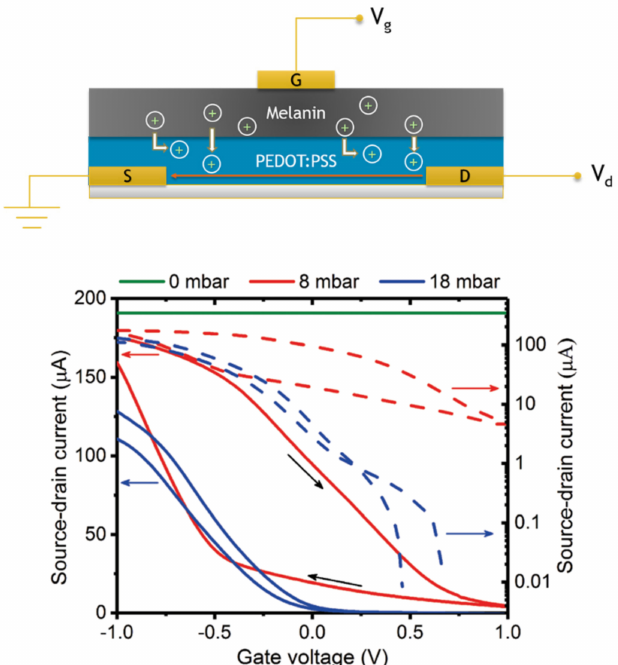
Figure 14. ( Top ) A schematic of the solid state organic electrochemical transistor from Sheliakina et al. The three terminal device is made of a bilayer utilizing poly(3,4-ethylenedioxythiophene) polystyrene sulfonate as the conductive channel and melanin as the ionic gate. ( Bottom ) Example transfer curves for the devices demonstrating on/off regimes as a function of an in situ hydration control. As can be seen, proper transistor function and sensitivity is recovered with hydration. Adapted